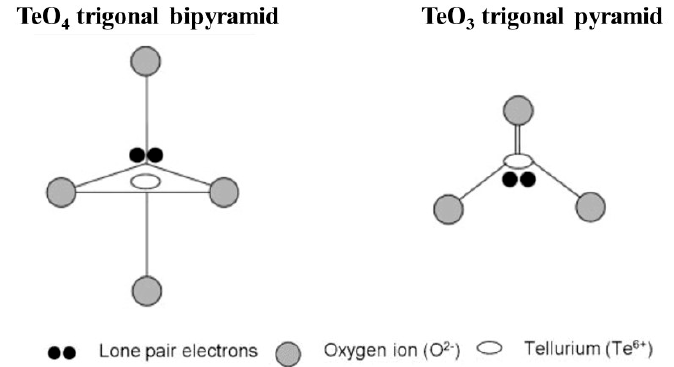
Figure 1. Schematic of the structural units in tellurite glasses, modified from [41].